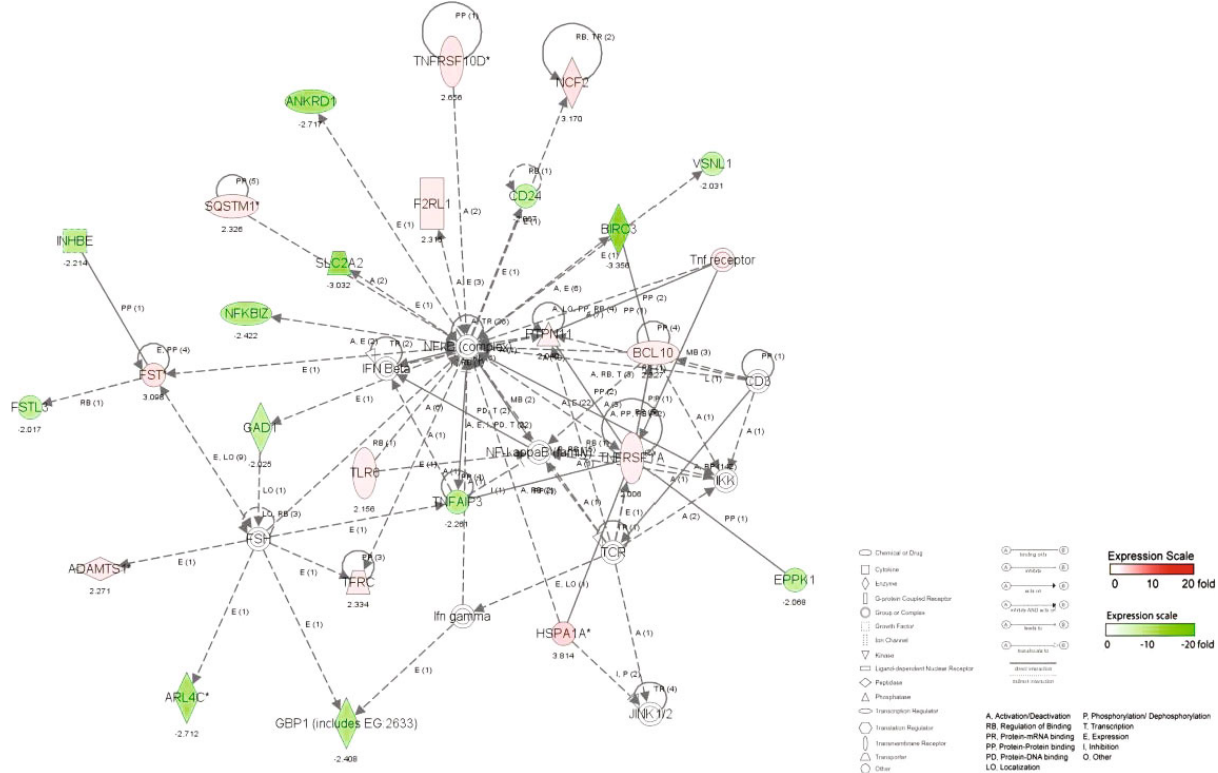
Figure 4: The most signi fi cant molecular network a ff ected by